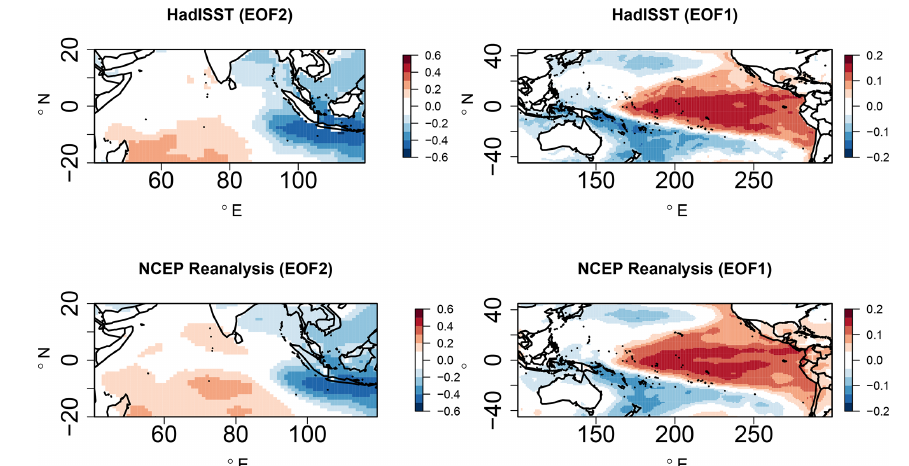
Figure 3. EOF2 patterns of SST anomalies (JJAS) in the Indian Ocean and EOF1 patterns in the Pacific Ocean for observed HadISST and NCEP